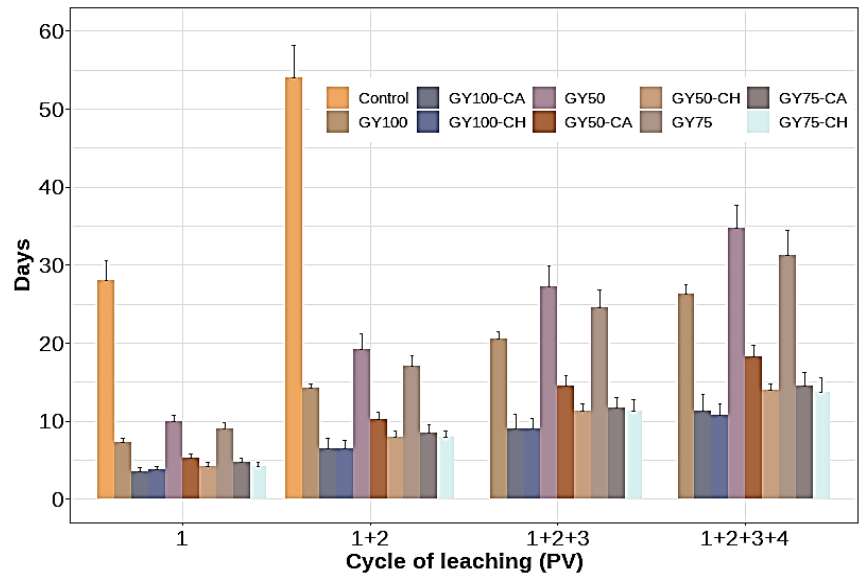
Figure 2. Percolation time in cumulate days according to the applied cycles of leaching as pore vol- umes. Cycles of leaching: 1 = first, 2 = second, 3 = third, and 4 = fourth. volumes. Cycles of leaching: 1 = first, 2 = second, 3 = third, and 4 =